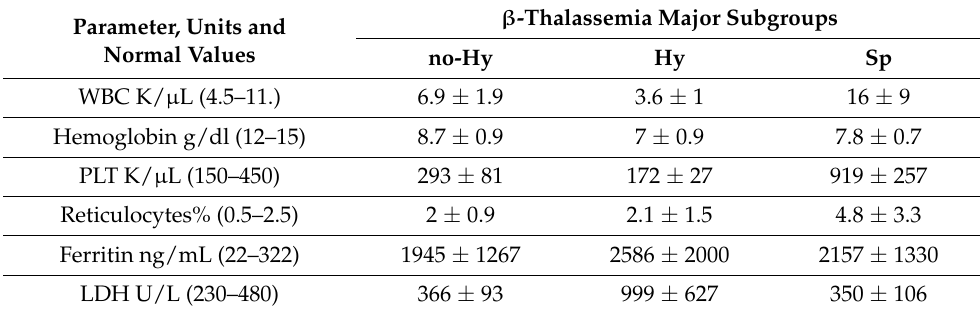
β -Thalassemia Major